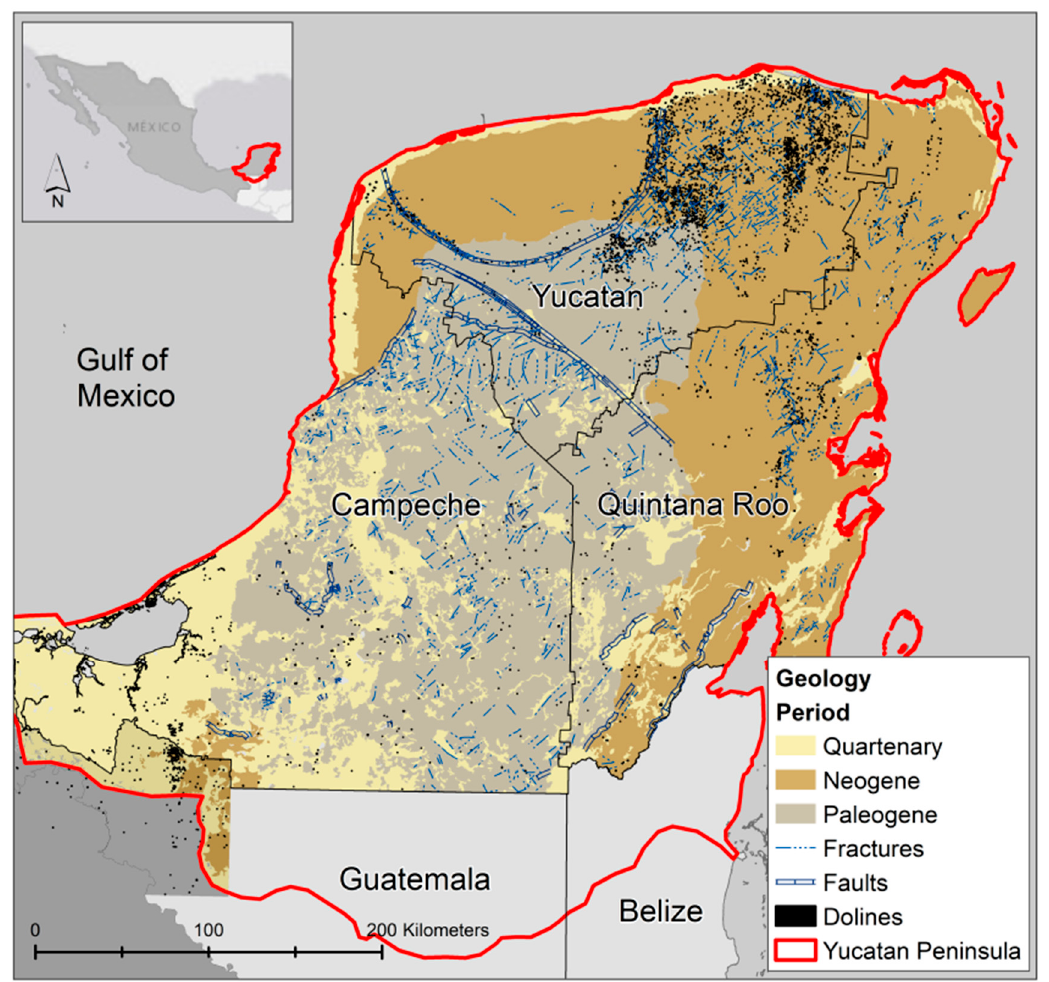
Figure 2. The Yucatan Peninsula geology according to Weidie [20].